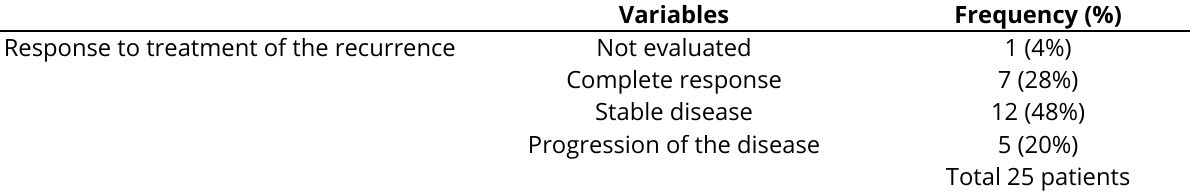
Table 4 – Treatment of recurrent cases (n): responses.